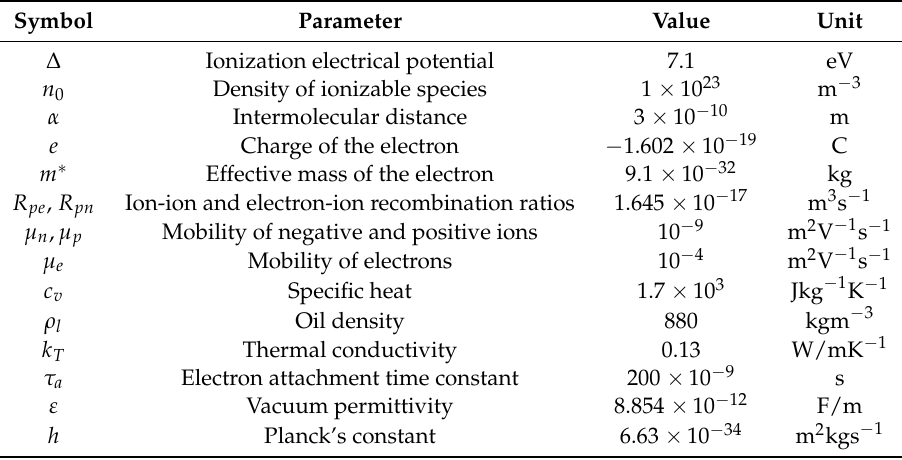
Table 2. Parameters used in the simulations for oil